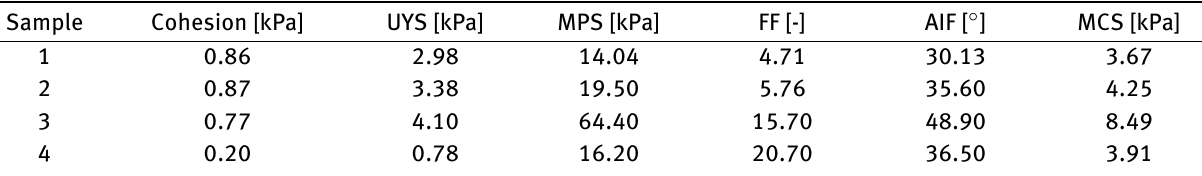
Table 2: Results from the shear cell flow experiments, measured at the consolidation stress of 9 kPa calcium carbonate, mica and perlite (samples 1, 2 and 4) and 22 kPa wollastonite (sample 3) and the temperature of 25 ∘ C